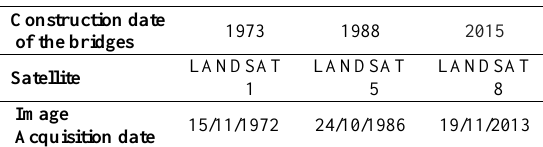
Table 1: Dates of the construction of the bridges and the images